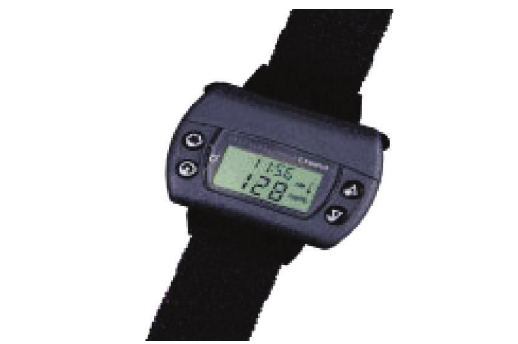
Figure 7: An image shows a list-watch type noninvasive blood glu- cose measurement [1]. The sensor can avoid damaging the tip of a finger or earlobe to sample blood in a noninvasive way. There- fore, it basically utilizes a quite low electric current to draw blood glucose penetrable through the skin. This sampled glucose is aggre- gated into a sensing part of the device integrating an electrode that is used for measuring blood glucose